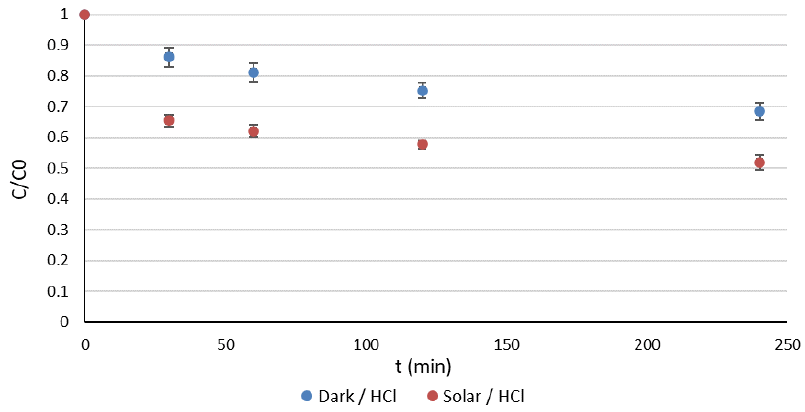
Figure 9. Duplicates of C 0 = 15 mg/L Cr(VI), in presence of 3 mM HCl and 1.2 g catalyst/L, under simulated solar irradiation and dark conditions, at pH 2.5.